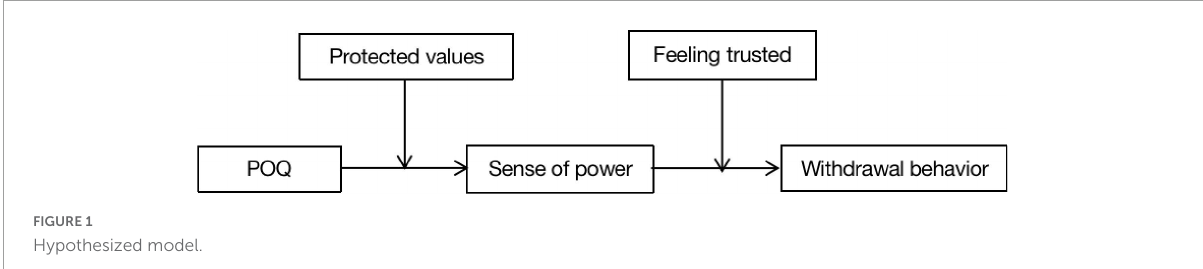
FIGURE1 Hypothesized model.